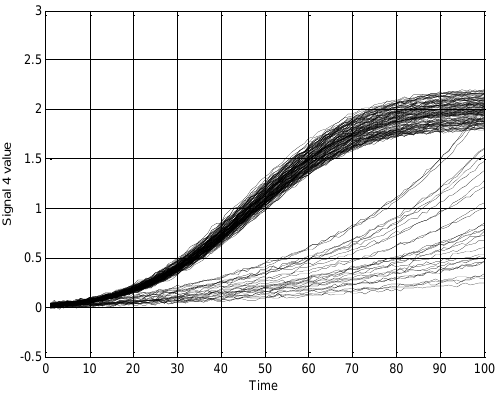
Fig. 4. Projection on the signal 4 axis of the 150 simulated